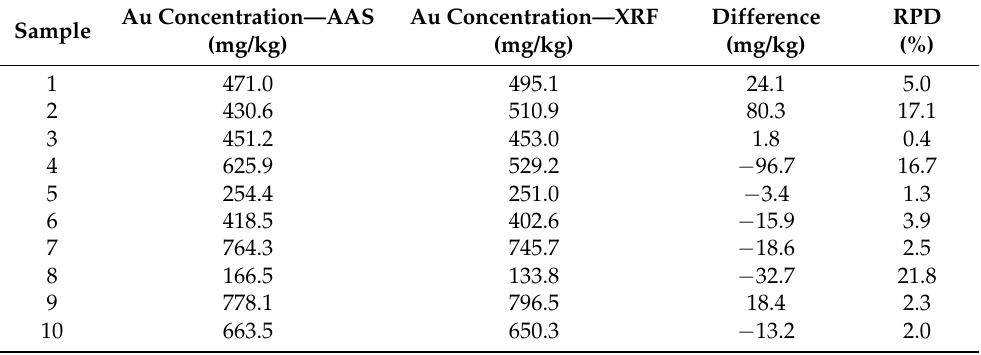
Table 2. Analysis of PCB samples: gold determination by XRF using the calibration curve and by AAS.